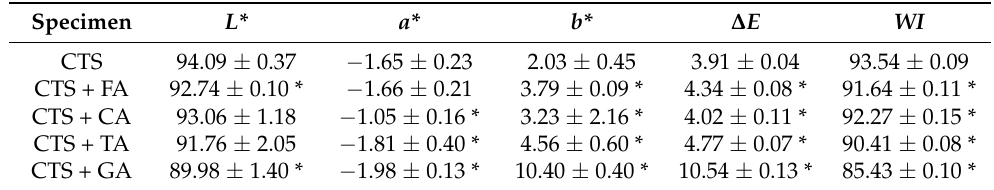
Table 5. The color values ( L*a*b* ), a total difference of color value ( ∆ E ), and whiteness index ( WI ) of films based on chitosan modified by phenolic acids. (* significantly different from CTS— p < 0.05).